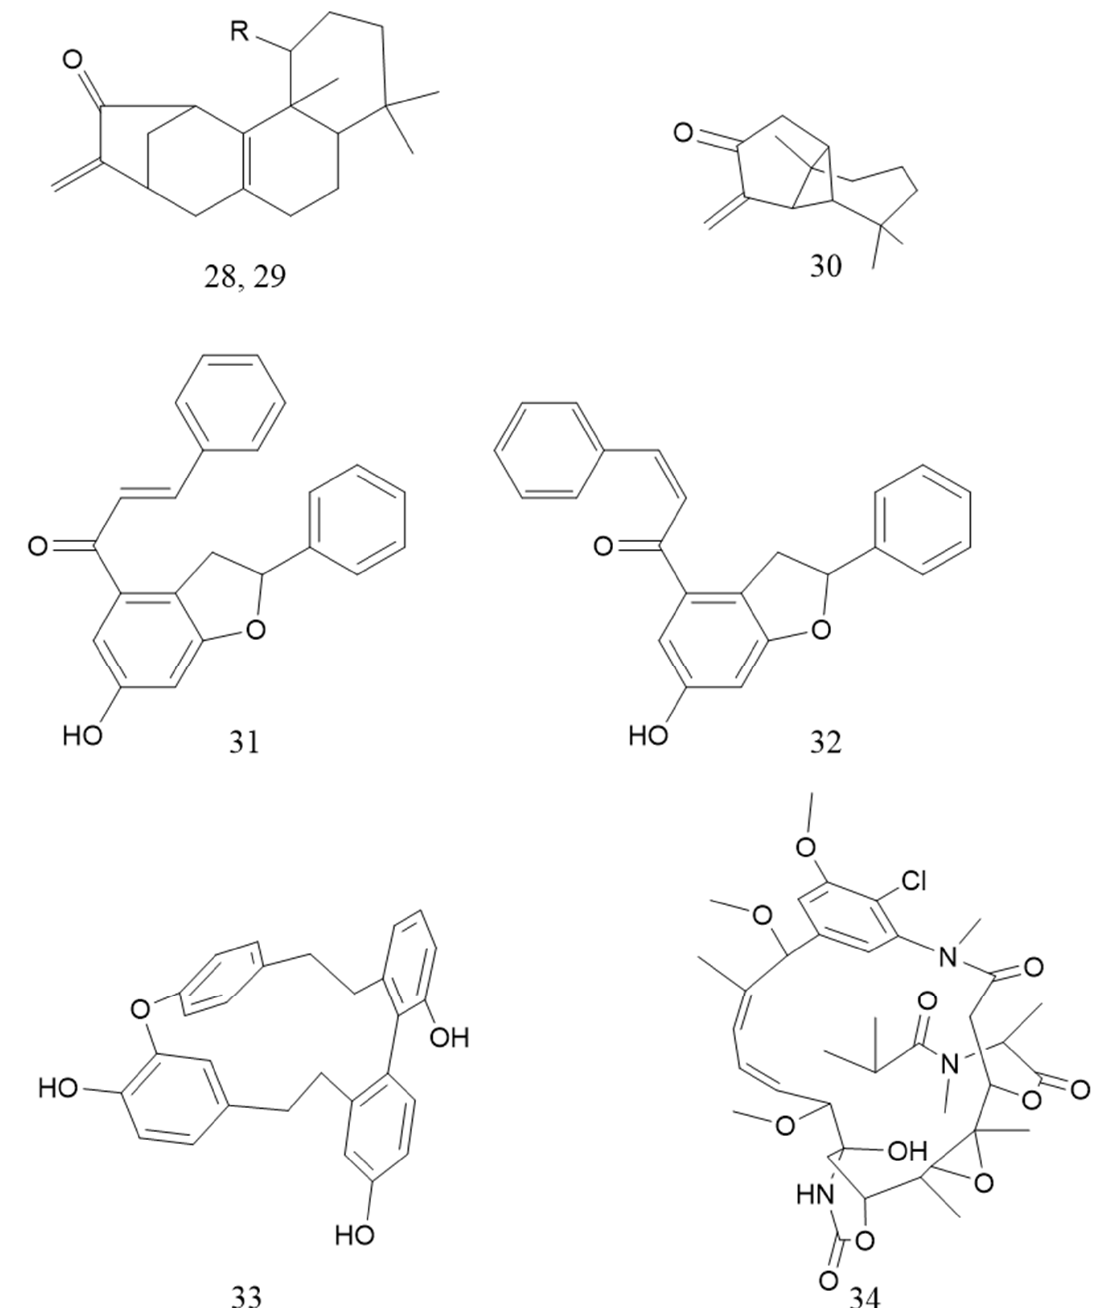
Figure 4. Compounds mentioned in Table 6 ( 28 : jungermannenone A, R=OH; 29 : jungermannenone B, R=H; 30 : marsupellone; 31 : pallidisetin A; 32 : pallidisetin B; 33 : plagiochin E; 34 : trewiasine).